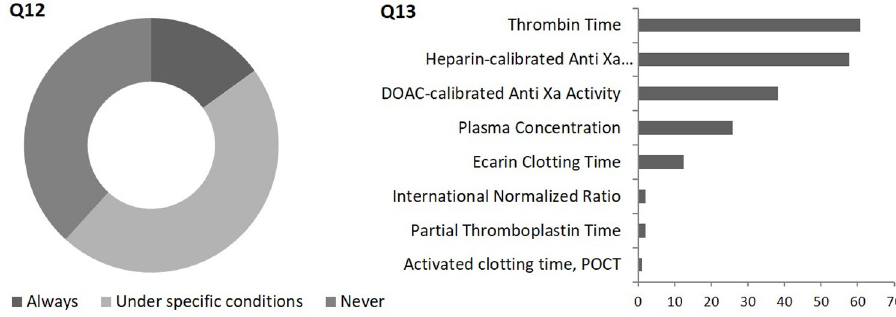
Fig 3. Question (Q) 12 (n = 160): Do you perform specific coagulation tests in patients with an acute ischemic stroke and non-valvular atrial fibrillation under treatment with direct oral anticoagulants?